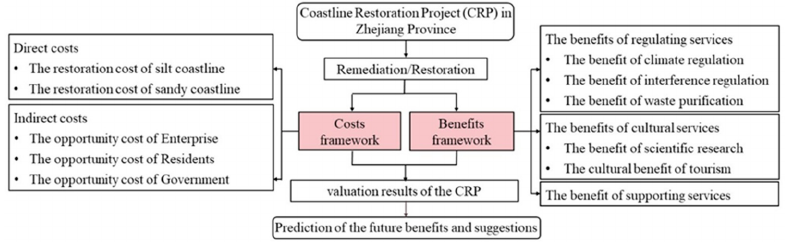
Figure 2. The analyzing framework of costs and ecosystem services (ES) for the three-year coastline ecological restoration project in the coastal cities of Zhejiang.